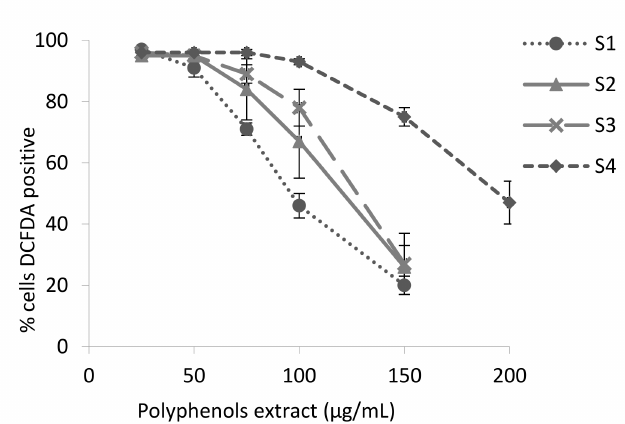
Figure 2. Inhibitory capacity of the digested blackberry juice polyphenols against intracellular ROS. Each value is the mean ± S.E. (three independent